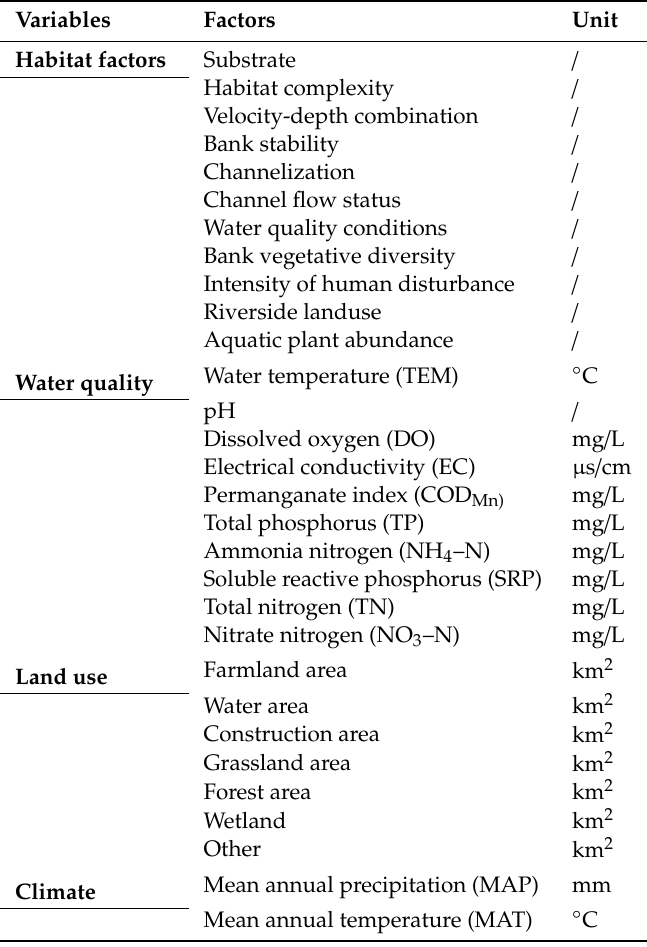
Table 1. List of all explanatory